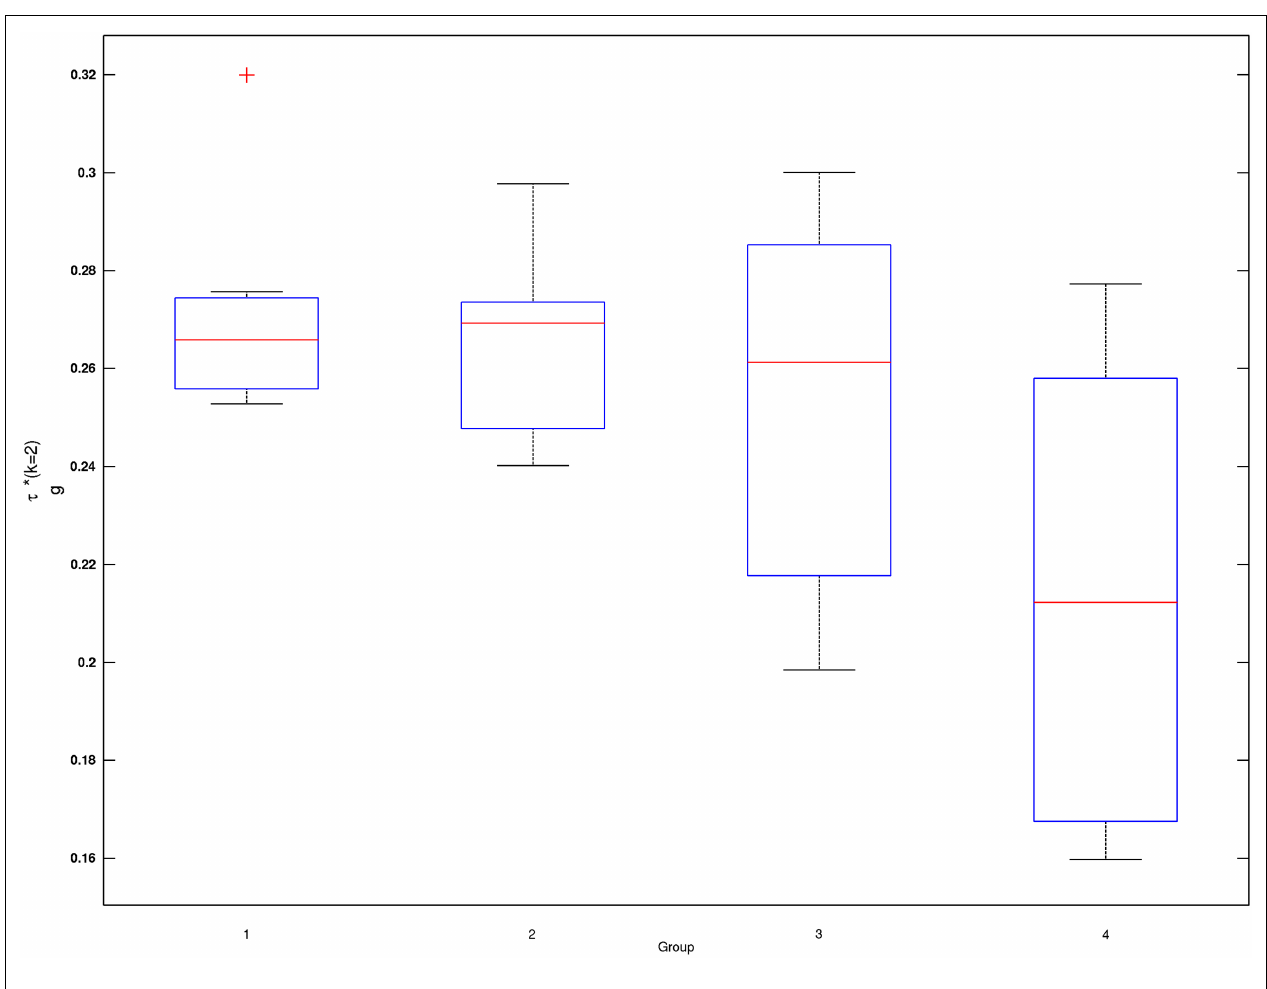
the age groups ( G = 1, 2, 3, 4). Outliers in each box plot, marked with red + signs, are defined as values that are more than 1.5 times the interquartile range away from the top or bottom of the